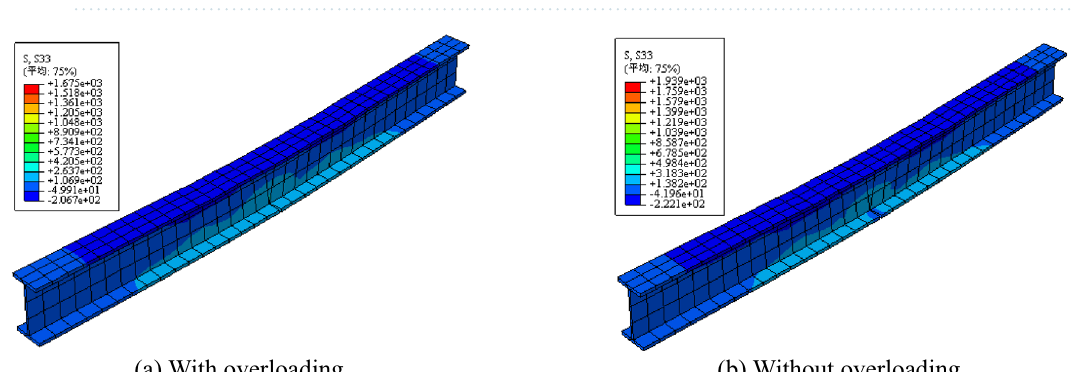
Figure 13. Stress comparison of steel beam with or without overloading.